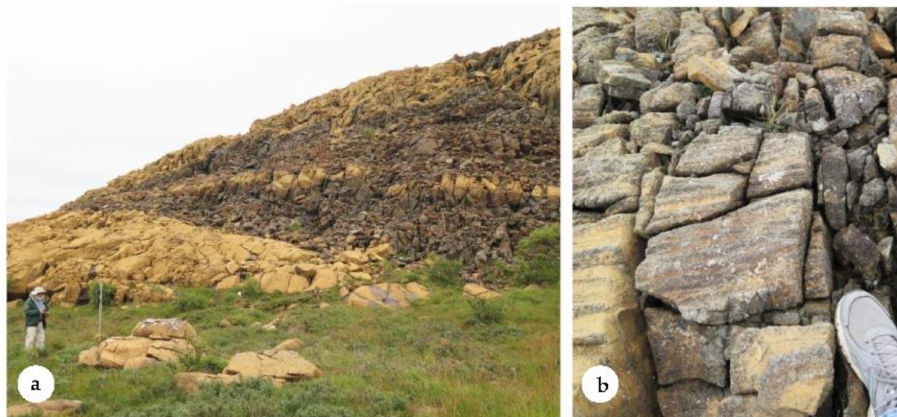
Figure 7. Natural fracture pattern in chromite layers interbedded with dunite exposed in the south wall of Støypet valley: ( a ) view to the south at the northeast end of Støypet valley showing chromite layers approximately 4 m thick and ( b ) close-up view showing vertical joints spaced about 40 cm